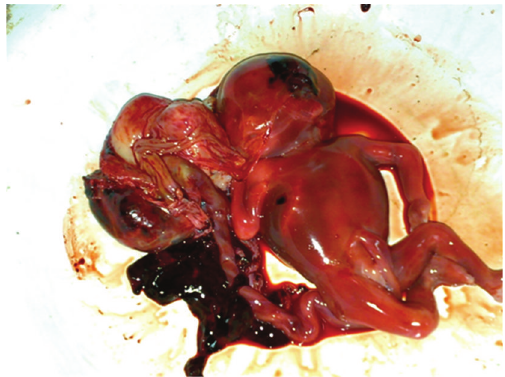
Figure 3: Fetus with